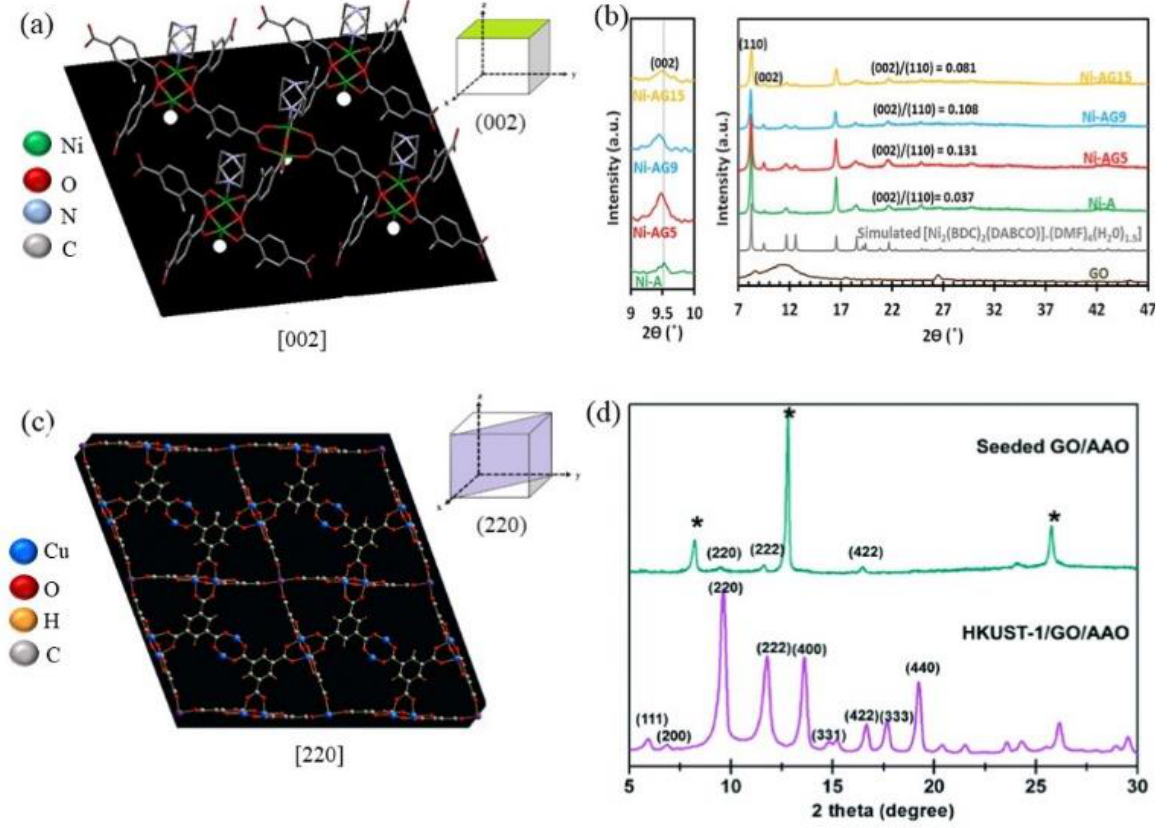
Figure 2. Structural analysis for the influence of GO film on the growth of ( a ) Ni–MOF, ( b ) X-ray Power Diffraction (XRD) patterns of simulated MOFs and composites, ( c ) HKUST-1, and ( d ) XRD data during the consecutive seeding and hydrothermal reactions. Reproduced with permission from [39,43]. Copyright 2017 and 2016, Elsevier and Royal Society of Chemistry.